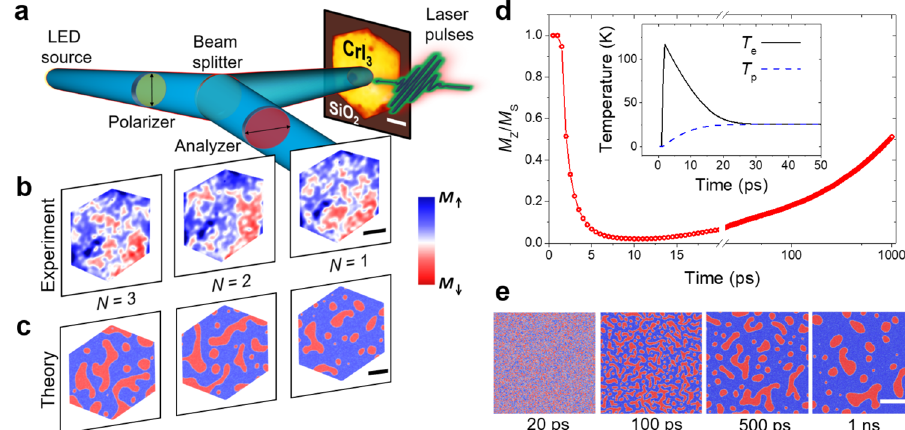
Fig. 1 | Demagnetization and optically induced domain formation in CrI 3 (sample 1). a Schematic of the experimental setup and optical image of a ~40nm bulk CrI 3 fl ake on Si/SiO 2 (sample 1). Magnetic domains are imaged in a wide- fi eld Kerr microscope (WFKM), by detecting polarization changes of the re fl ected light due to the polar Kerr effect, following excitation with laser pulses. b Formation of domain structure after consecutive single laser pulses ( N =1, 2, 3) with 1.88eV photonenergy,linearpolarization,~30fspulsedurationand fl uence F =3.4mJ/cm 2 . The blue (red) color scale represents the Kerr signal corresponding to